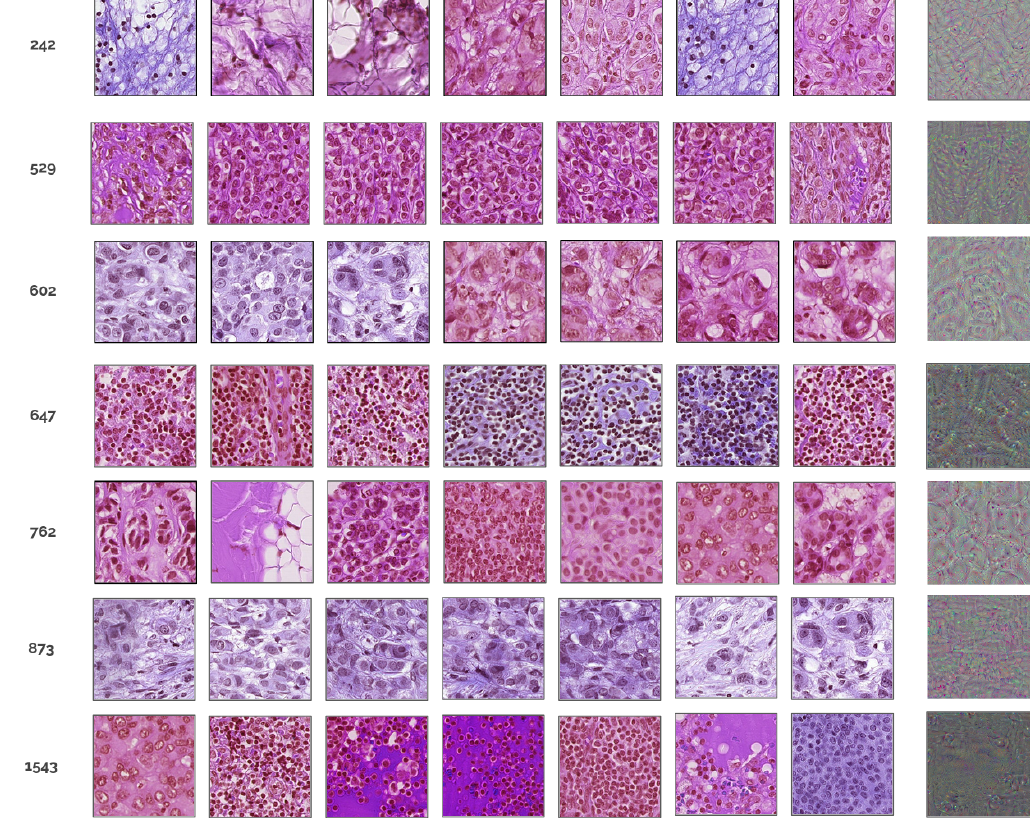
Figure A4. Features selected by Attention-based model to describe “tumor”